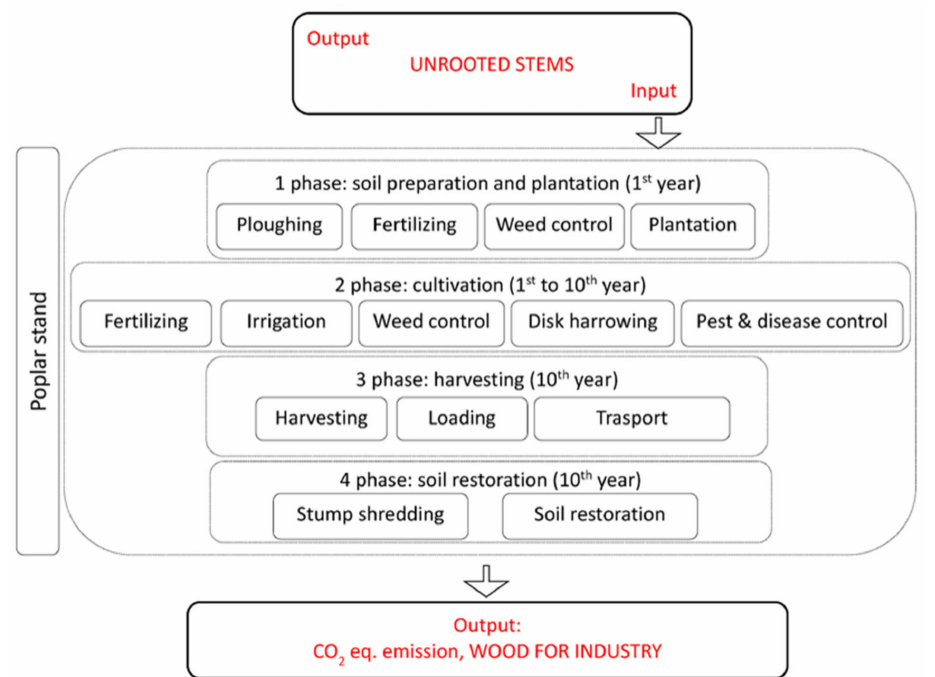
Figure 1. System